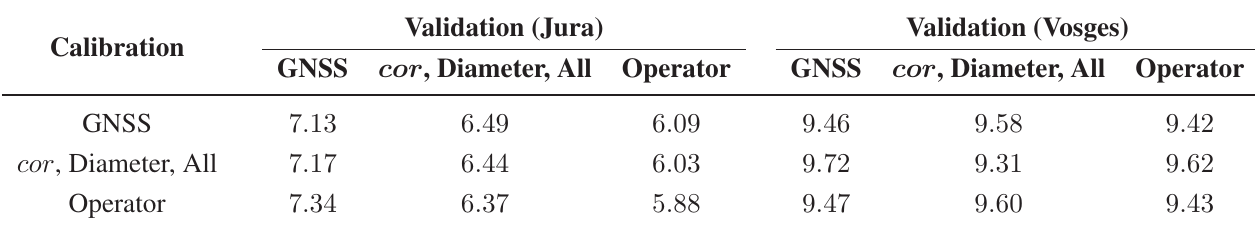
Table 4. Root mean square error of basal area prediction models (1000 repetitions of ten-fold cross-validations) depending on the plot positions used in the calibration and validation steps, for the two study areas. Units are in m 2 · ha − 1